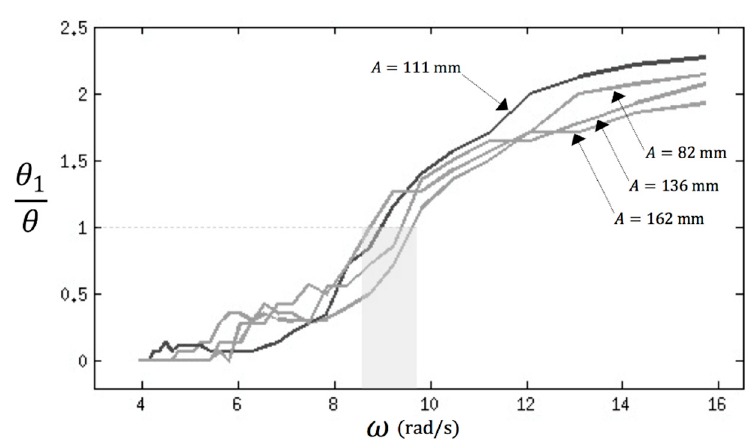
Figure 13. Elevation of θ 1 versus θ along ω at different filling heights ( A ) when AFS uses SIM.